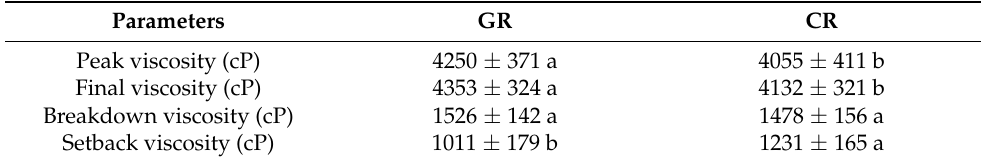
Setback viscosity (cP) 1011 ± 179 b 1231 ± 165